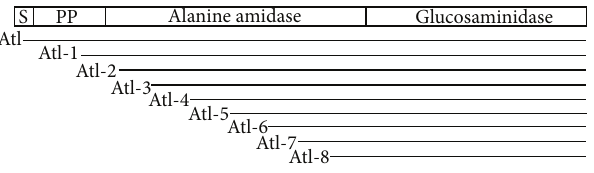
Figure 1: Diagrammatic representation of full-length staphylococ- cal atl and various shortened atl gene fragments that were cloned for overexpression in E. coli . The full length Atl ( ∼ 137kDa) possesses a signal peptide, a propeptide, and two catalytically active amidase and glucosaminidase